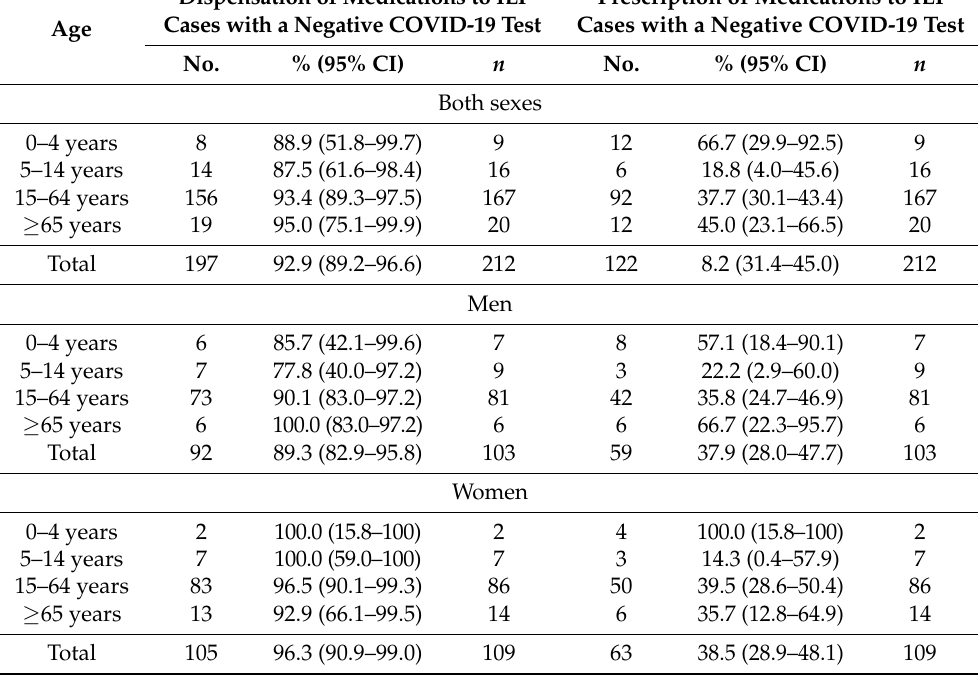
Table 3. Percentage of dispensation and percentage of medications to influenza-like illness (ILI) patients with a negative COVID-19 test in Catalonia (Spain) in the 2021–2022 influenza season. Dispensation of Medications to ILI Prescription of Medications to ILI Cases with a Negative COVID-19 Test Cases with a Negative COVID-19 Test Age No. % (95% CI) n No. % (95% CI)